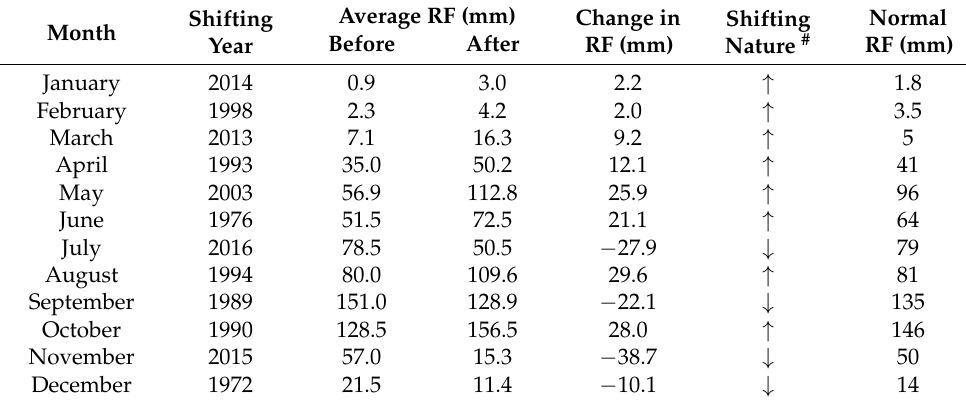
Table 5. Shifting pattern of monthly rainfall (mm) over